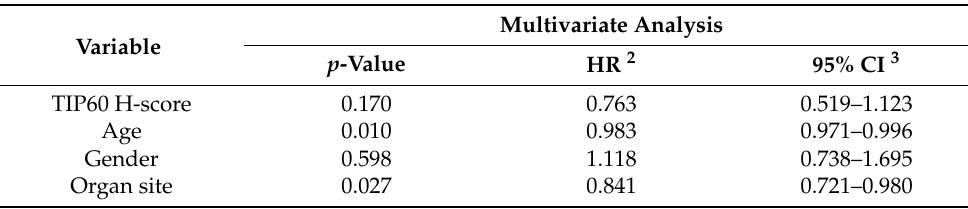
Table 3. Multivariate analyses including TIP60 protein levels for 4-year MSS 1 in stage IV mela- noma patients.